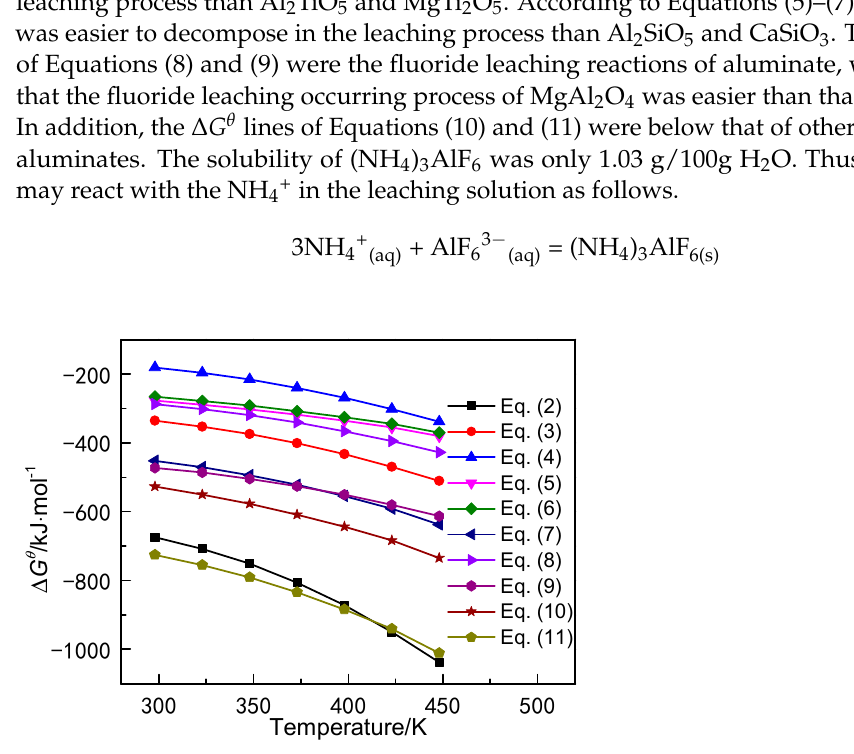
Figure 3. ∆ G θ – T relationship lines of the possible reactions during fluoride leaching.